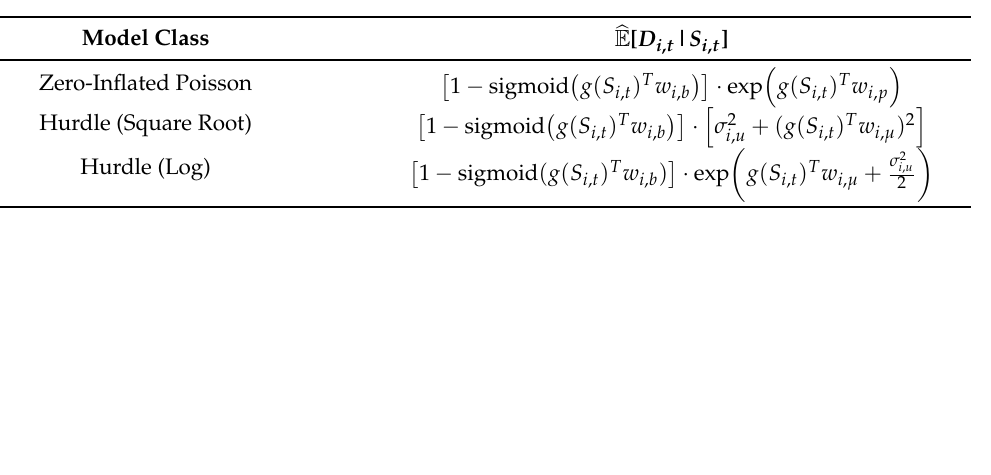
Table A1. Definitions of (cid:98) E [ D i , t | S i , t ] for each model class. (cid:98) E [ D i , t | S i , t ] is the mean of user model i fitted using data { ( S i , t , D i , t ) } T t = 1